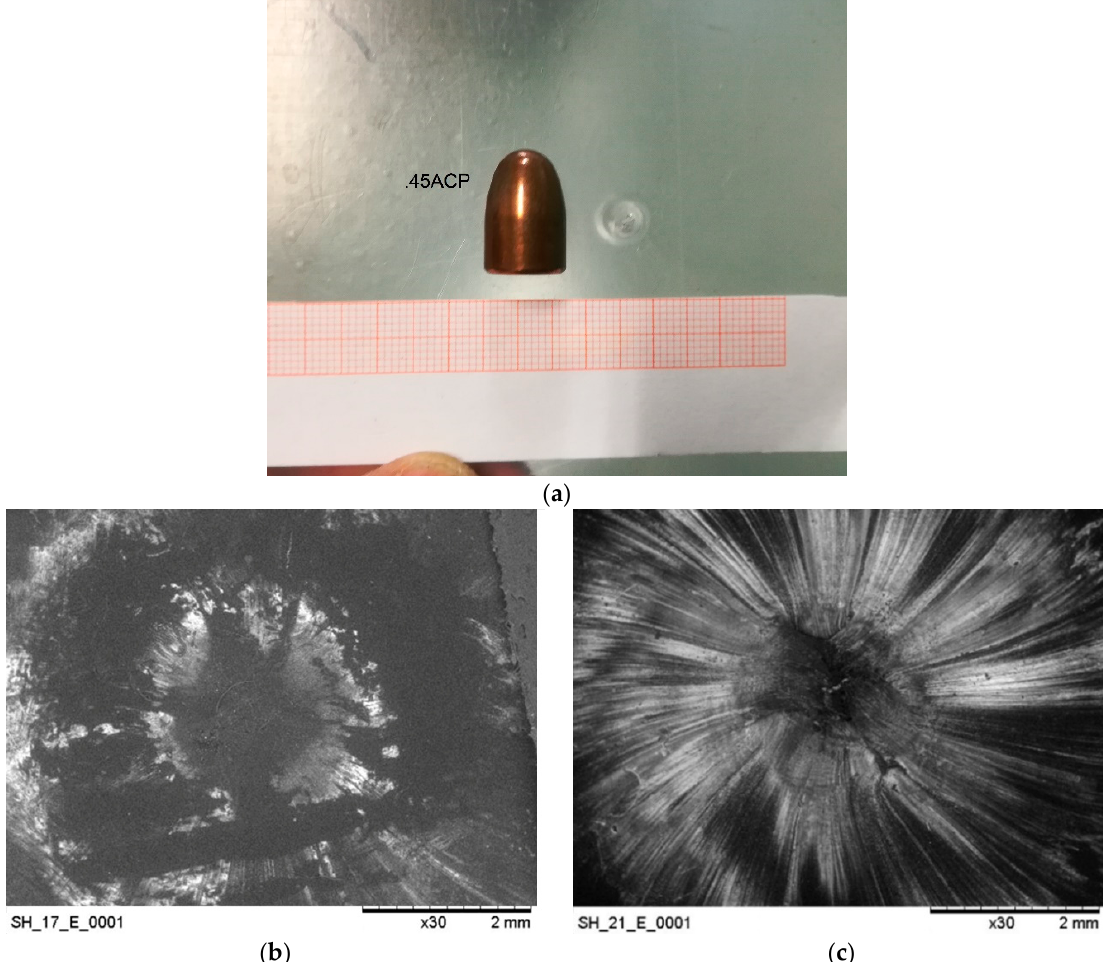
Figure 8. Self-healed panel after bullet puncture ( a ). SEM images of punctured EMAA panels with ( b ) and without ( c ) the presence of lubricant.